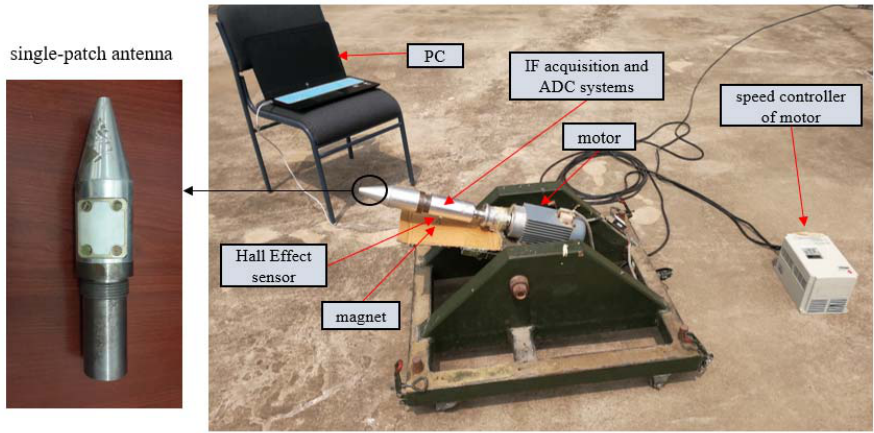
Figure 20. Experiments on a single-axis rotary table.